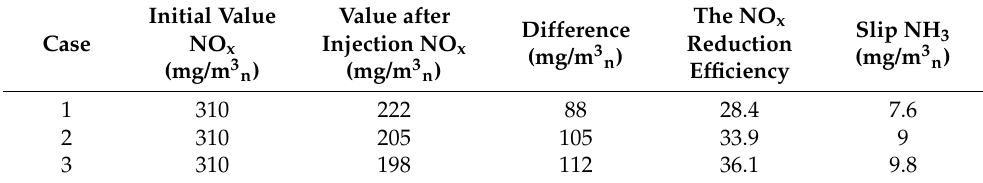
Table 10. NOx reduction results for 3